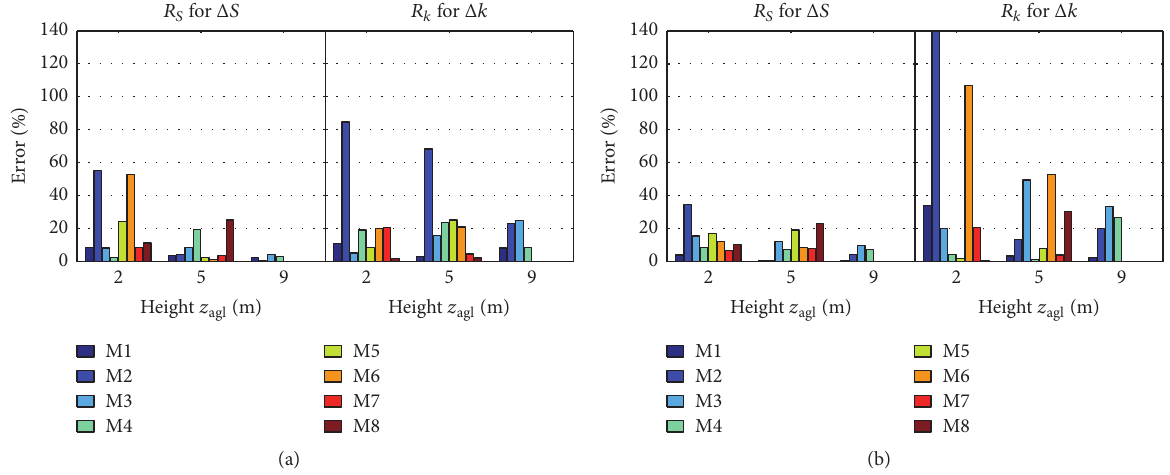
Figure 11: Simulation errors: 𝑅 𝑆 for speedup and 𝑅 𝑘 for TKE increase errors in the case of 270 ∘ (a) and 239 ∘ (b) wind directions.